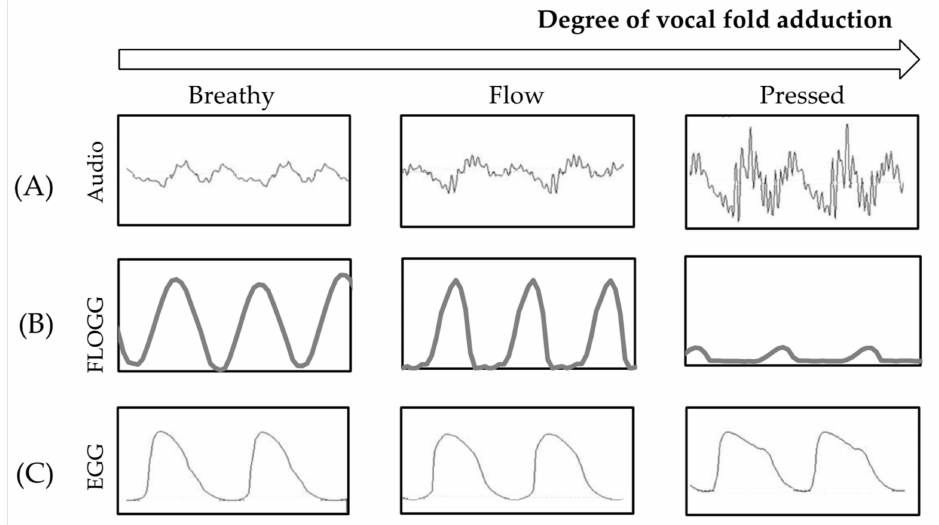
Figure 14. Examples of three phonation types—breathy, flow and pressed—and corresponding ( A ) audio signals, ( B ) flow glottograms (FLOGG) and ( C ) EGG shapes, displayed by the software Sopran, recorded with an omnidirectional microphone, a flow mask and an electrolaryngograph. The shapes of both FLOGG and EGG signals reflect different types of